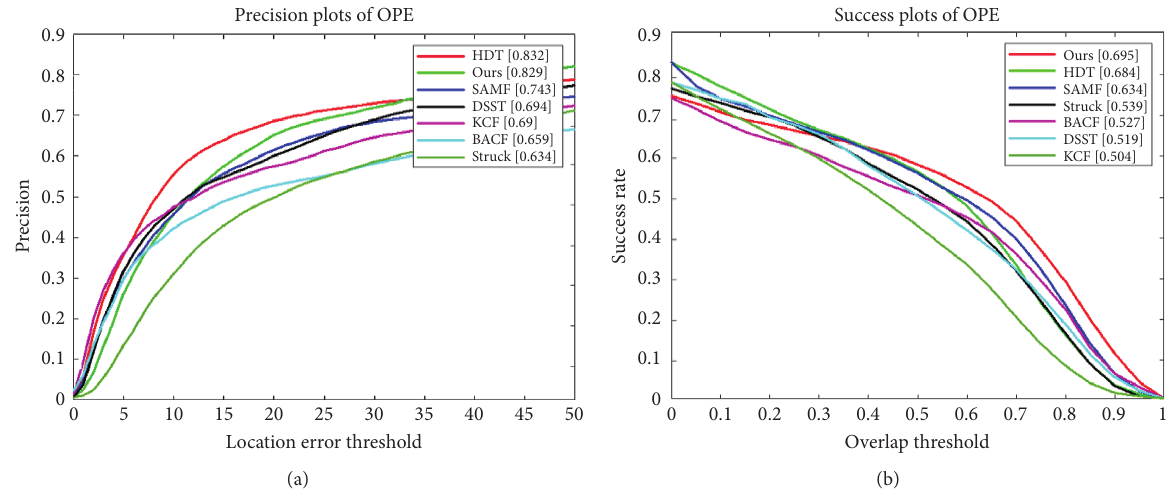
Figure 7: Distance precision and overlap success plots on the 100 benchmark sequences of OTB2015 [31] datasets using OPE. The legend of distance precision contains the threshold scores at 20 pixels, while the legend of overlap success contains area under the curve scores for each tracker.